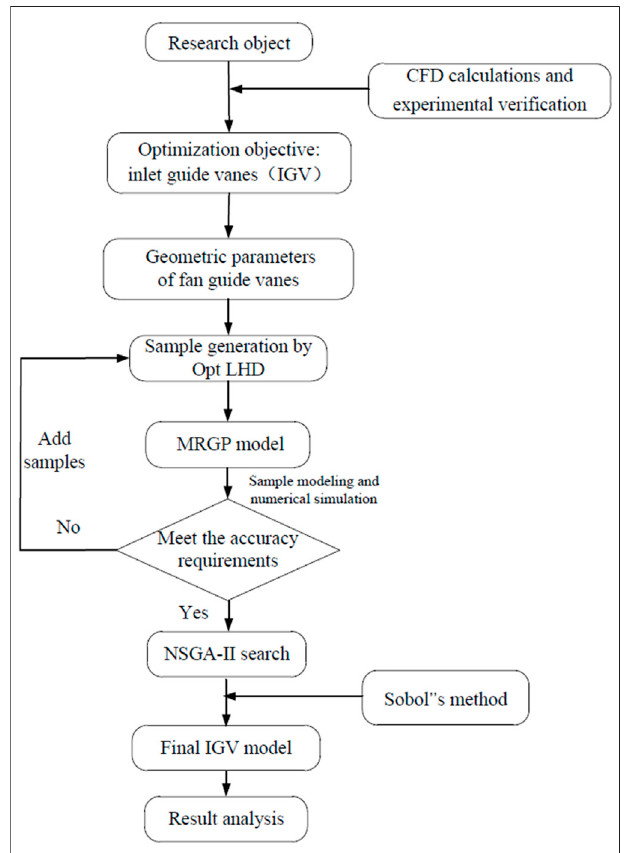
FIGURE 1 | Optimization fl ow